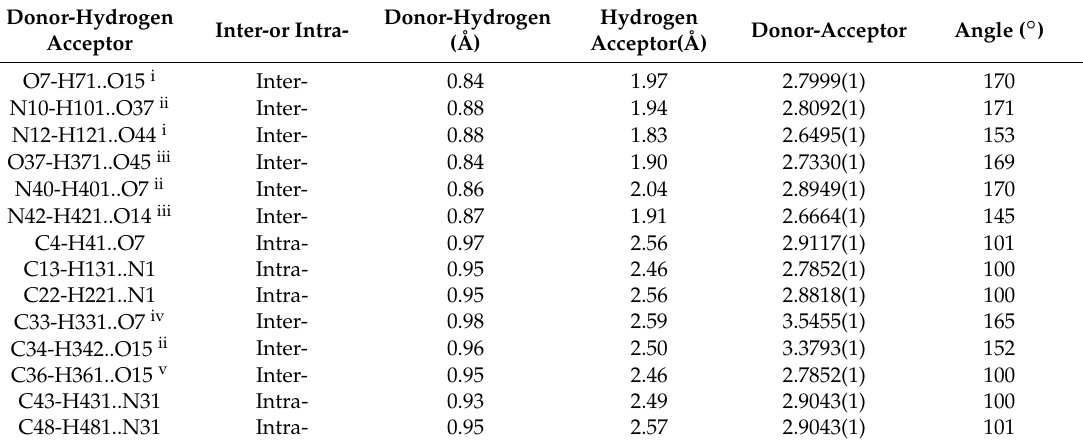
Table 2. Hydrogen bonding interactions displayed in 3 showing inter- and intramolecular bonds.